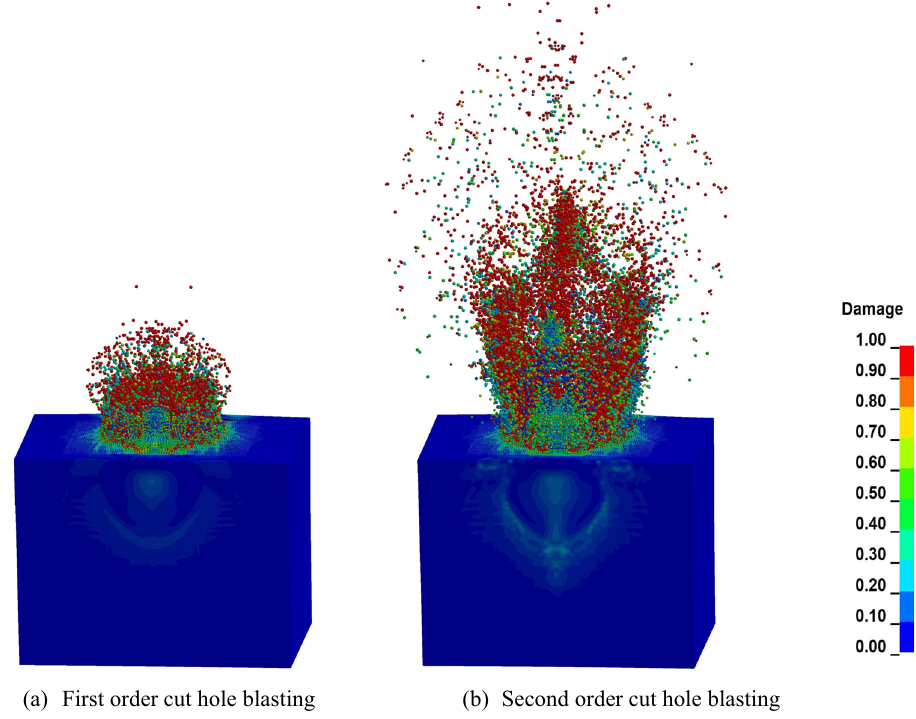
(a) First order cut hole blasting (b) Second order cut hole Fig. 21 Double triangle cut blasting. a First order cut hole blasting; b Second order cut hole blasting